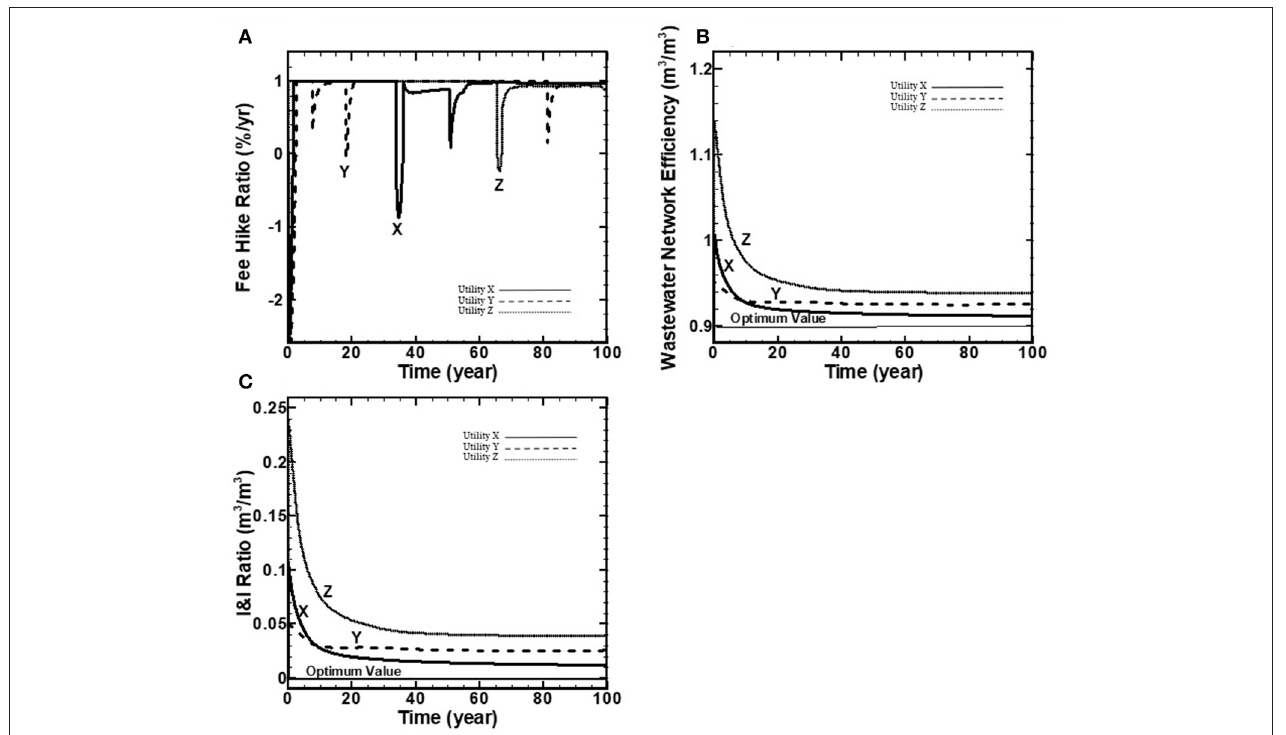
FIGURE 4 | (A–C) Wastewater socio-political performance indicators over a 100-year benchmarking